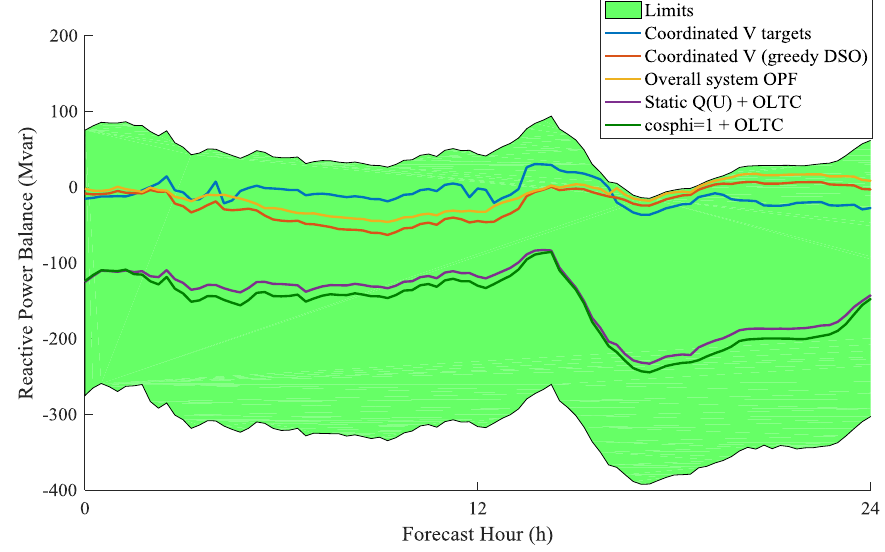
Figure 17. Reactive power exchange between transmission and distribution grid (daily).